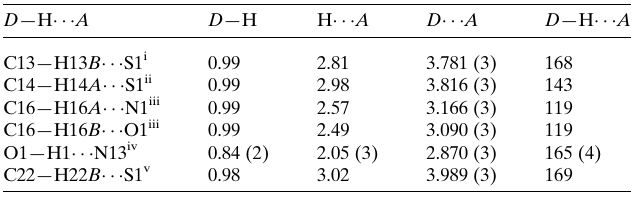
Table 3 Hydrogen-bond geometry (A˚ , (cid:5) ) for 1 .